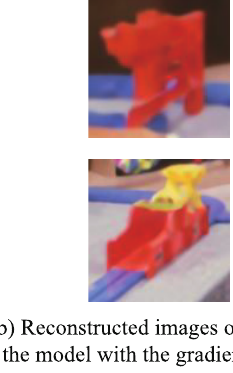
Figure 7. Comparison of the reconstructed images obtained by different models.